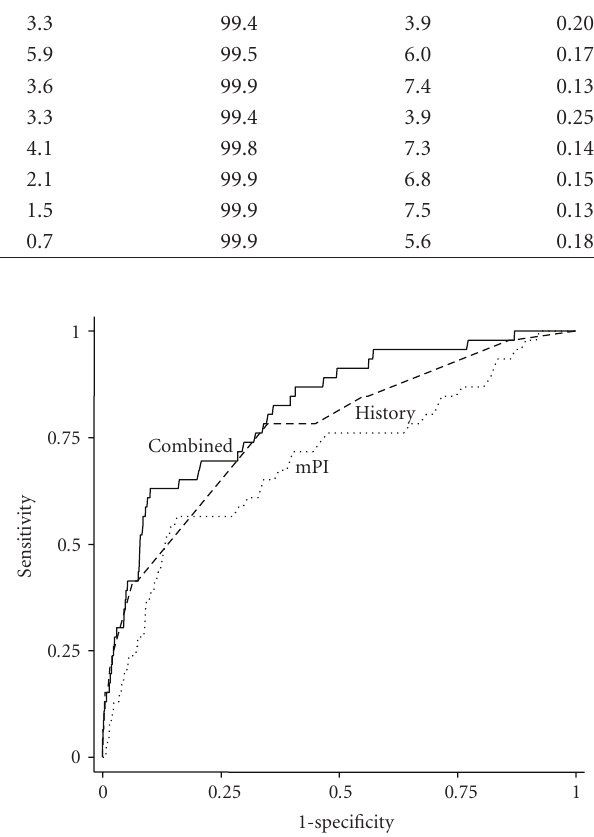
Figure 2: Receiver-operating characteristic curves showing the sensitivities for given screen-positive rates of uterine Doppler mean PI assessment (mPI), maternal history characteristics (History) and the combination of both methods (Combined) in the detection of early-onset PE.